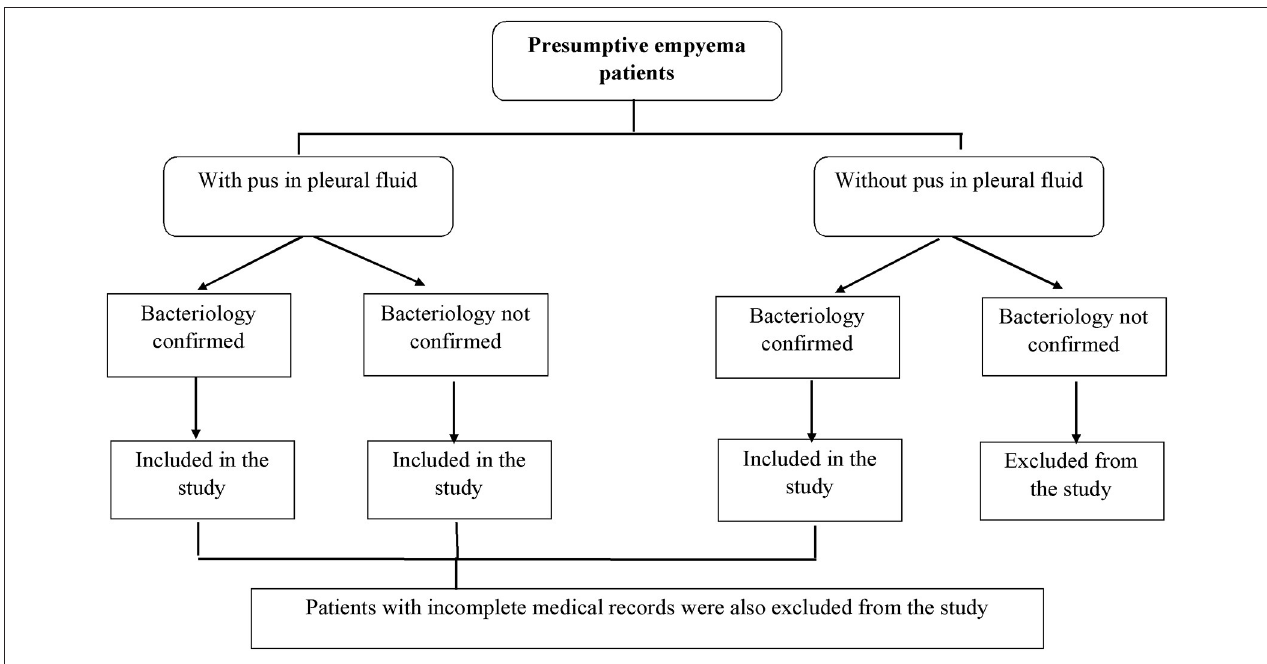
FIGURE 1 | Description of the patients who met the inclusion